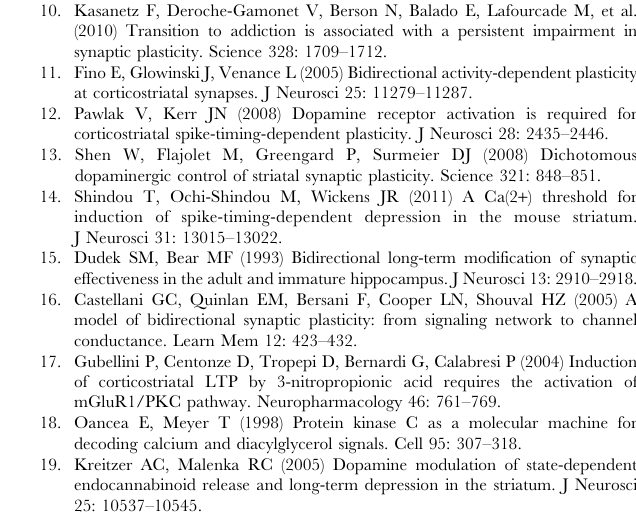
Figure S1 Calcium concentration resulting from the stimulation for DSI simulation. (A) 100 ms depolarization (B) 1s depolariza- tion, (C) 5s depolarization. In all cases onset is at 2 sec. Red traces show calcium in the spine head, black traces show calcium in the dendrite. The blue bar represents the stimulation time. Though mean values are similar, fluctuations in the spine head are much greater due to the smaller volume.